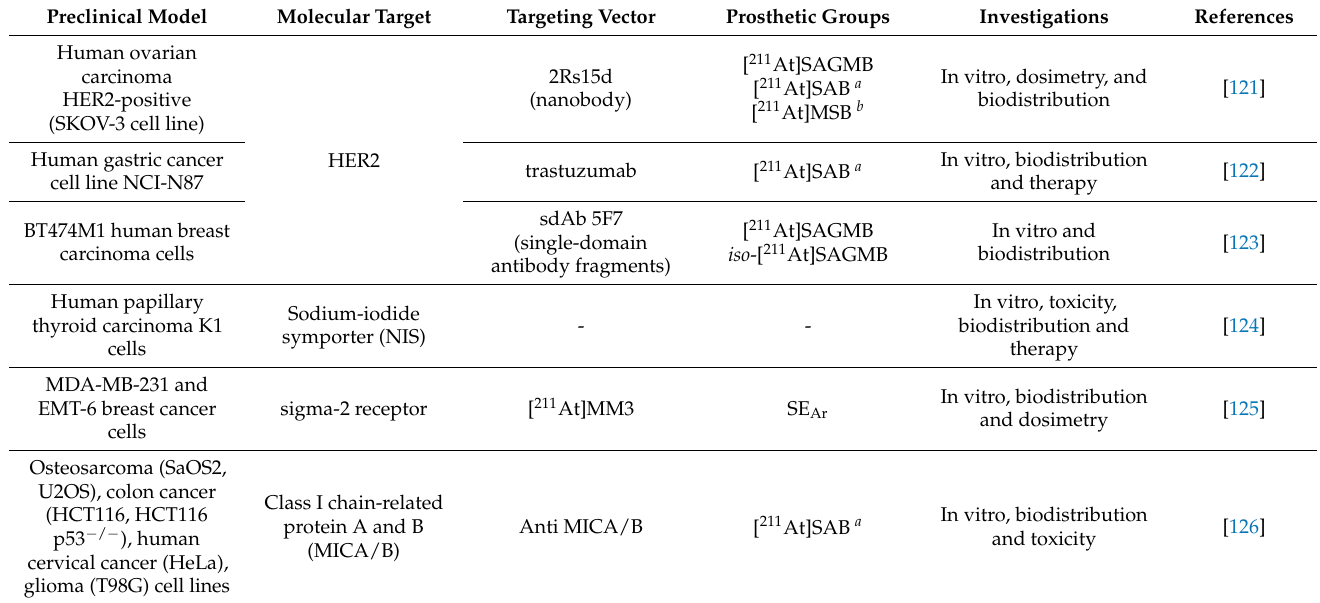
Table 2. Preclinical studies involving an identified pathology model (non-exhaustive